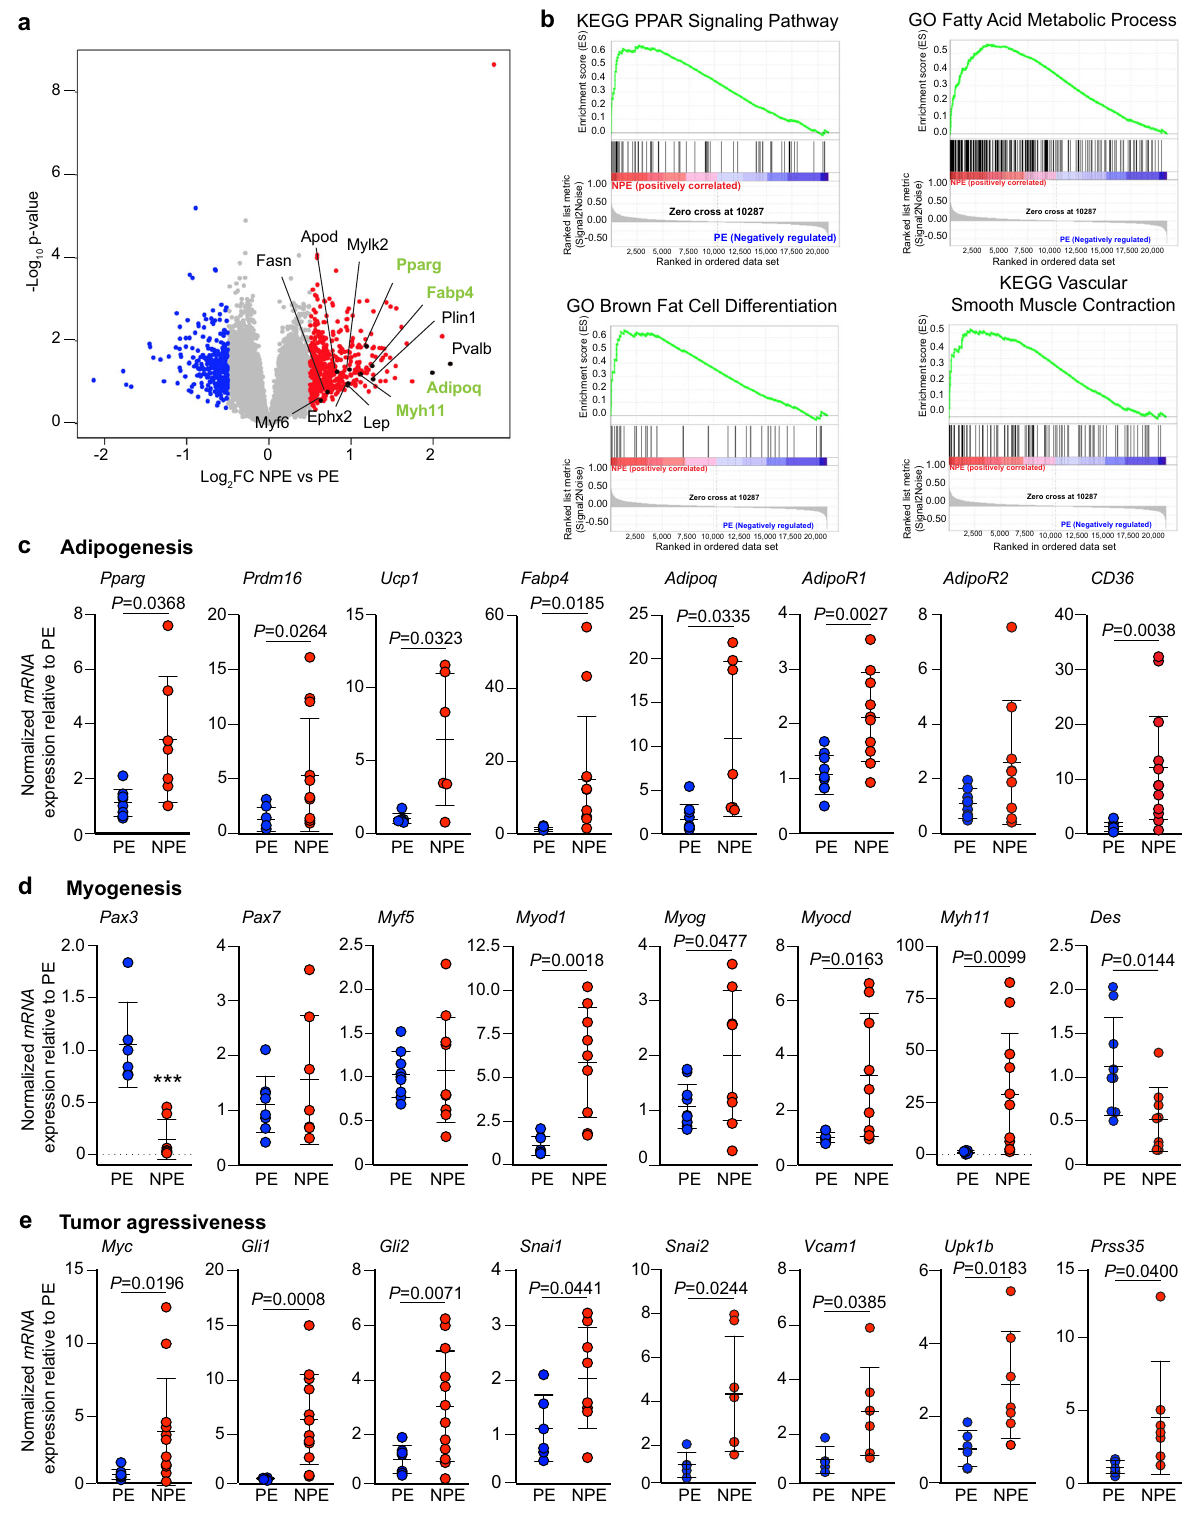
(Fig. 6e). It is noteworthy that the top-upregulated gene in NPE vs PE RMS is H2Eb1 , encoding the mouse histocompatibility class II antigen E beta (MCH II), which is involved in antigen presentation, CD4 + T cell recognition and activation of the immune response 60 (Fig. 6a). The relevance of this observation will require extensive future study exploring the immune response component of these tumors, which is beyond the scope of this